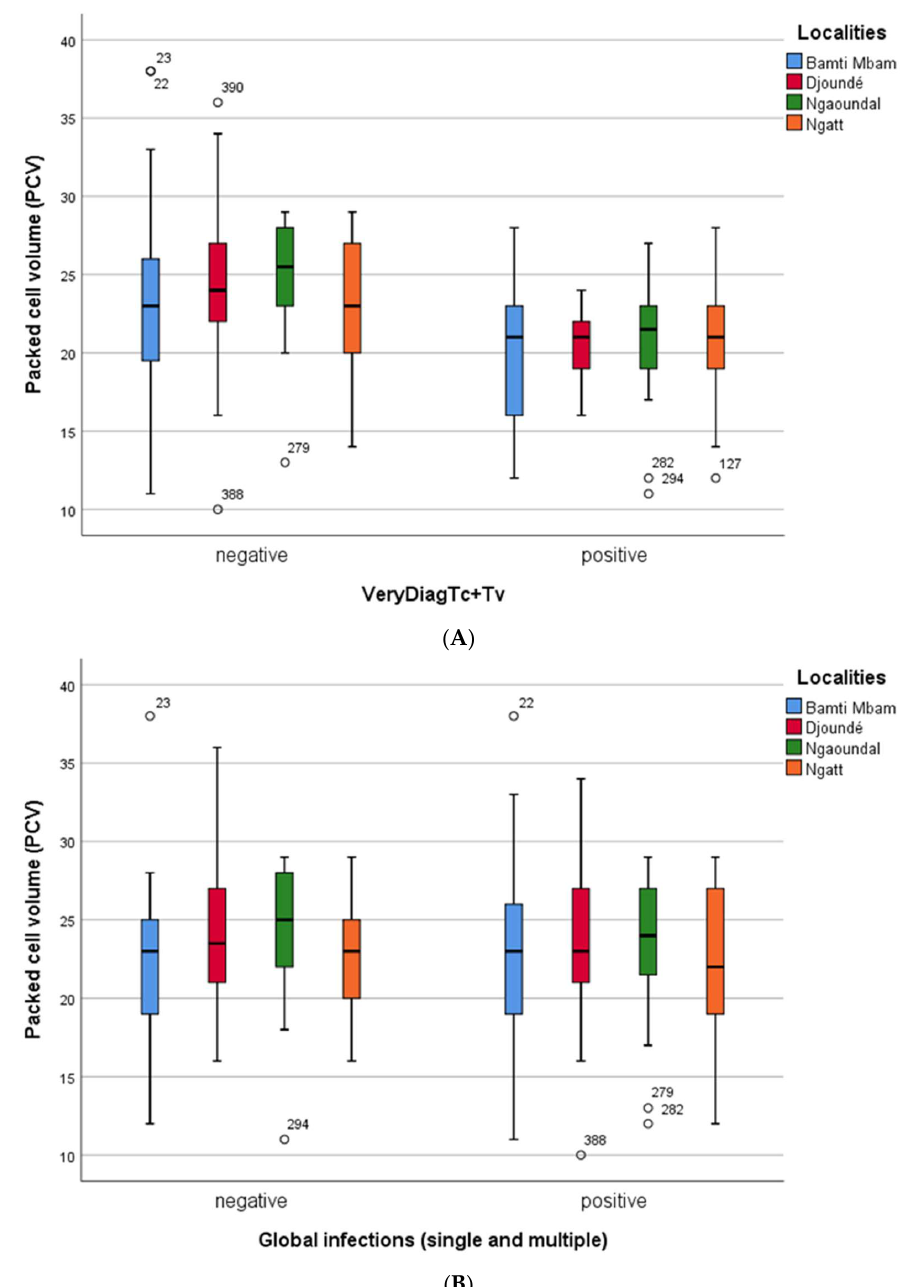
Figure 3. ( A ) Comparison of hematocrit rate (PCV) of trypanosome-infected (whatever the infecting species) and uninfected cattle, in the four sampling sites. Here, cattle infection was identified using the Very Diag Kit. ( B ) Comparison of hematocrit rate (PCV) of trypanosome-infected (whatever the infecting species) and uninfected cattle, in the four sampling sites. Here, cattle infection was identi- fied using PCR technique.